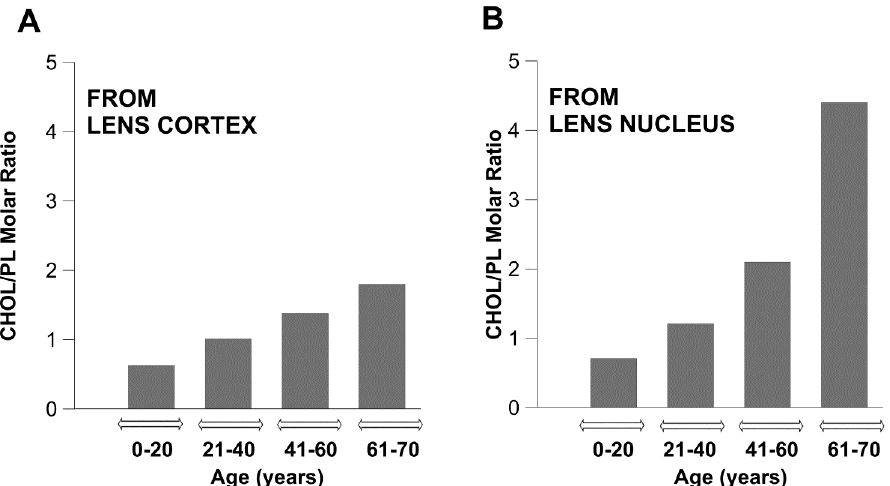
Figure 3. The cholesterol/phospholipid (CHOL/PL) molar ratio in cortical and nuclear lipid membranes of transparent eye lenses from human donors of different age groups. Values taken from [23].